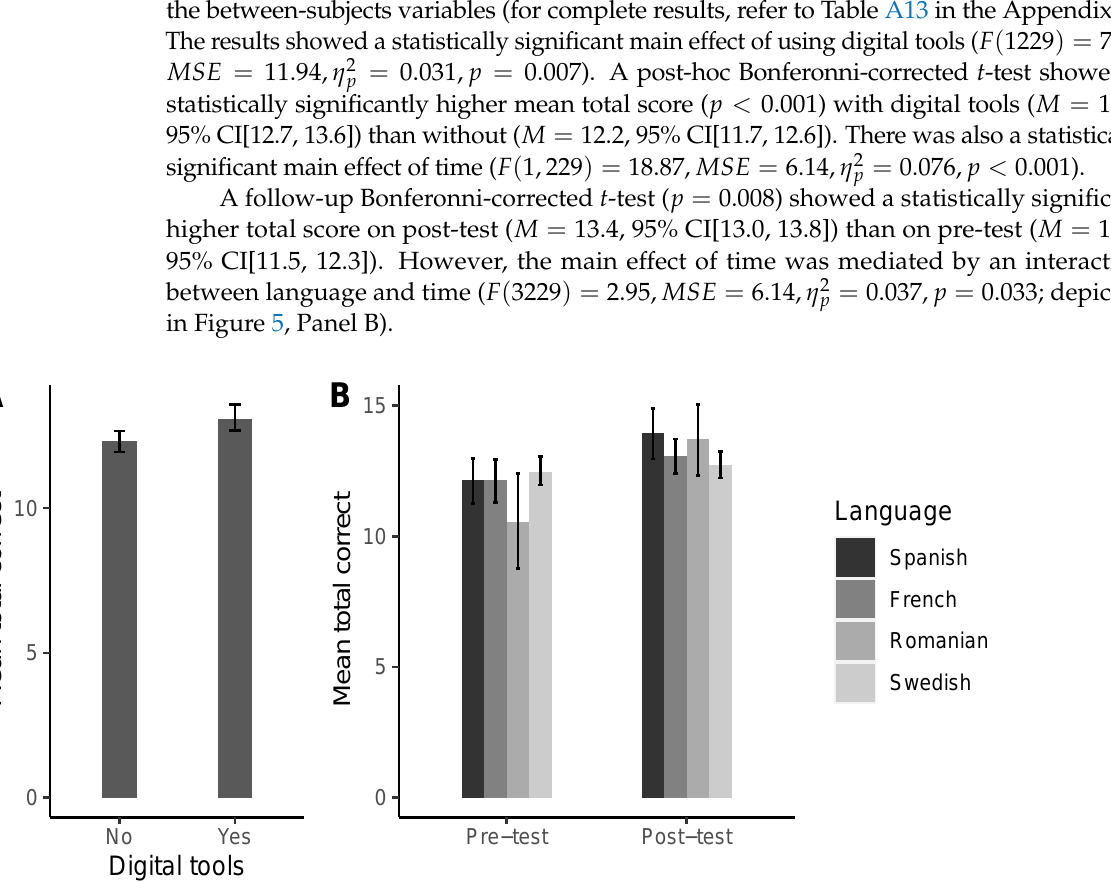
Figure 5. Panel ( A ) depicts the mean total score for participants not using/using digital tools in the post-test. Panel ( B ) depicts the mean total score on pre- and post-test for each language. Error bars denote a bootstrapped standard error of the